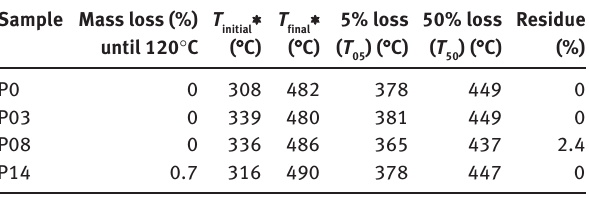
Table 4: TGA results of the polypropylene